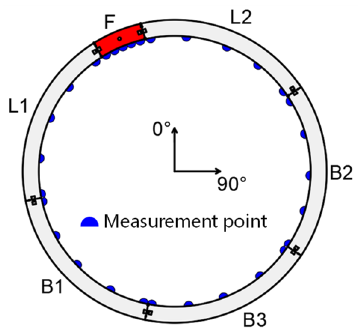
Figure 4. The position of virtual measurement points.